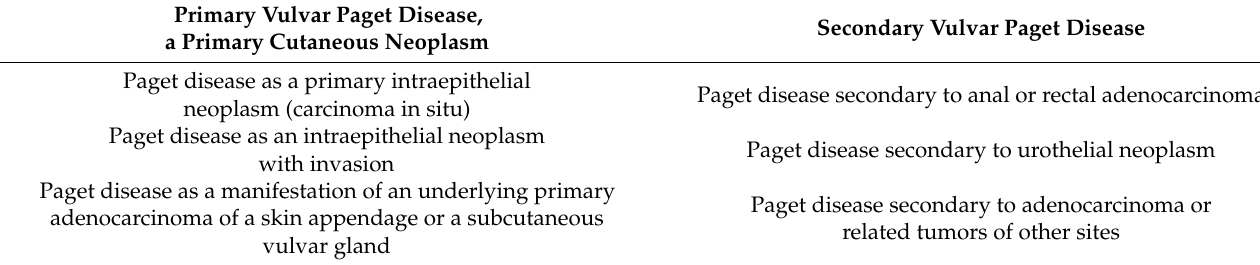
Table 1. Proposed classification of vulvar Paget disease